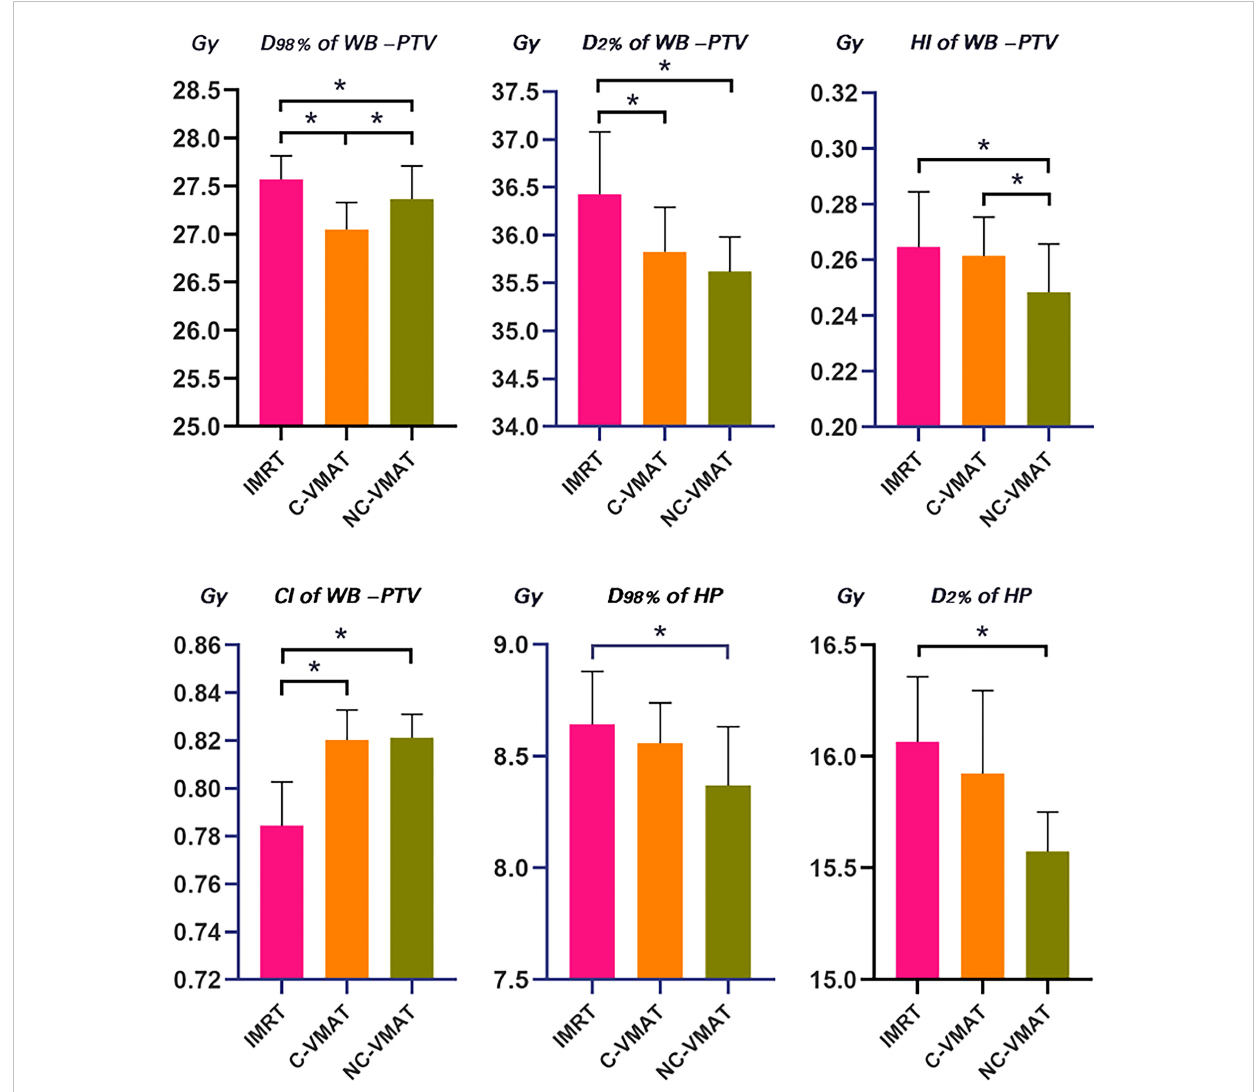
FIGURE 1 Comparison for mean values of D 98% , D 2% , HI and CI of WB-PTV and D 2% and D 98% of hippocampus for IMRT, C-VMAT and NC-VMAT plans. a. * p <0.05 (one-way ANOVA, LSD post-hoc test) b. HP, hippocampus c. Error bars was caculated by standard deviation